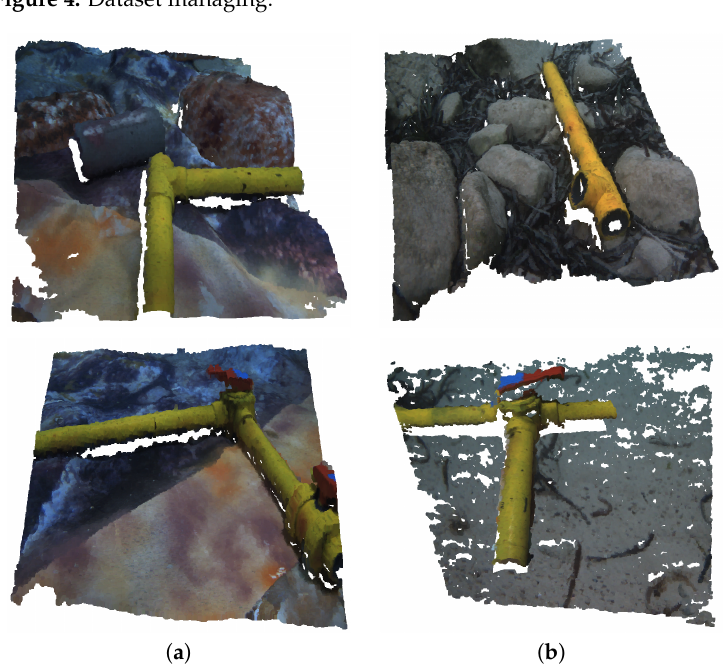
Figure 5. Examples of point clouds from ( a ) Pool dataset and ( b ) Sea